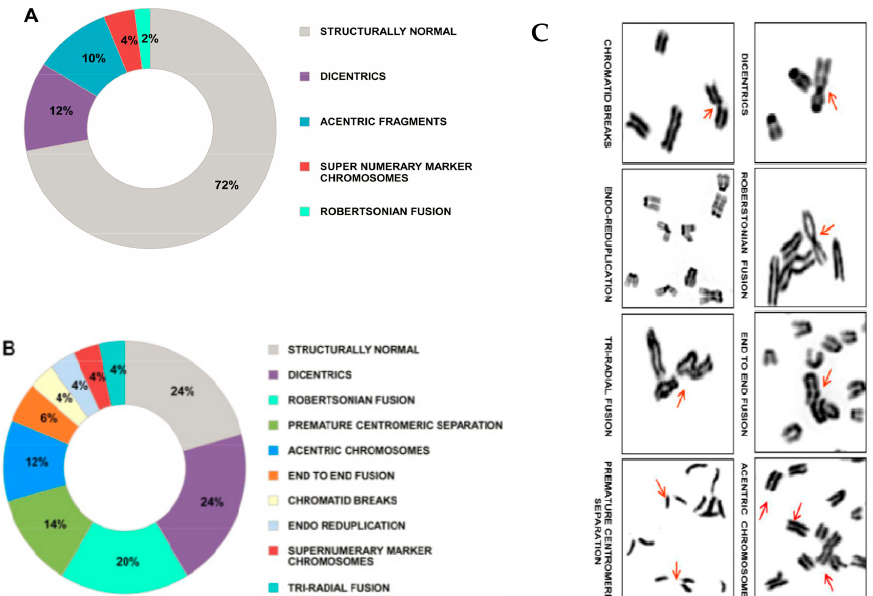
Figure 10. Chromosomal aberrations induced in healthy cells by cfCh released from dying cancer cells. NIH3T3 mouse fibroblast cells were grown in conditioned medium of irradiated (10 Gy) MDA-MB-321 human breast cancer cells for 96 h. Cell culture was continued in fresh medium and karyotype analysis was performed at the 10th passage. ( A , B ) wagon-wheel representation of chromosomal aberrations in control and conditioned medium treated NIH3T3 cells, respectively. Fifteen metaphases were analyzed in each case and average percentage values are given in the figures. ( C ) depiction of various chromosomal abnormalities. Reproduced from [84].